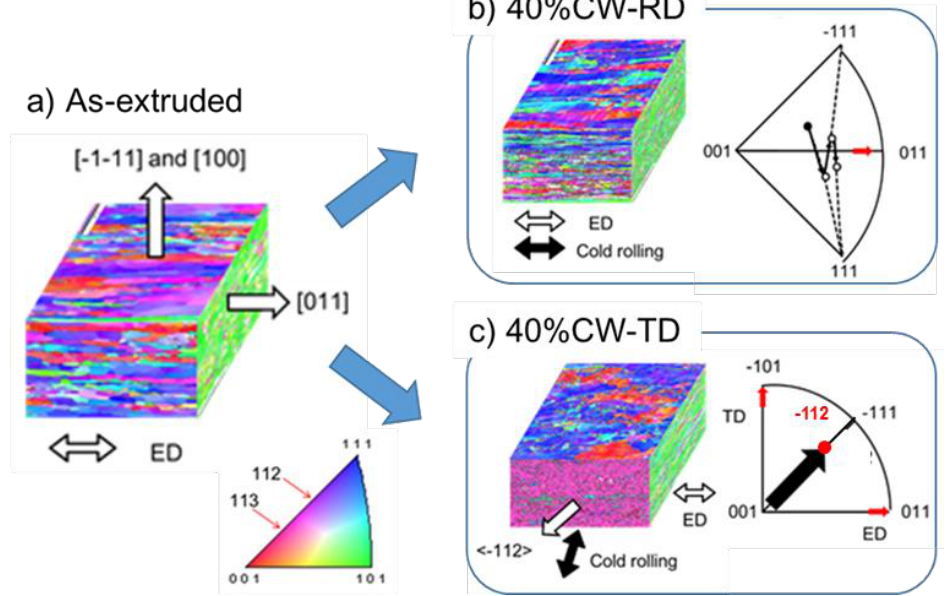
Figure 9. The effect of cold rolling on the 3D microstructure of deformation texture of Al-added ODS steel with a stereo-triangle of crystallographic orientation: ( a ) as-extruded, ( b ) 40%-CR and cold rolling direction is parallel to the extruded condition (ED), ( c ) 40%-CR and cold rolling direction is perpendicular to the extruded condition (TD). Noted that each surface of 3D microstructure is not conjunct with the single standard orientation of the rolling specimen surface, but they are just the orientation maps of observed surfaces.